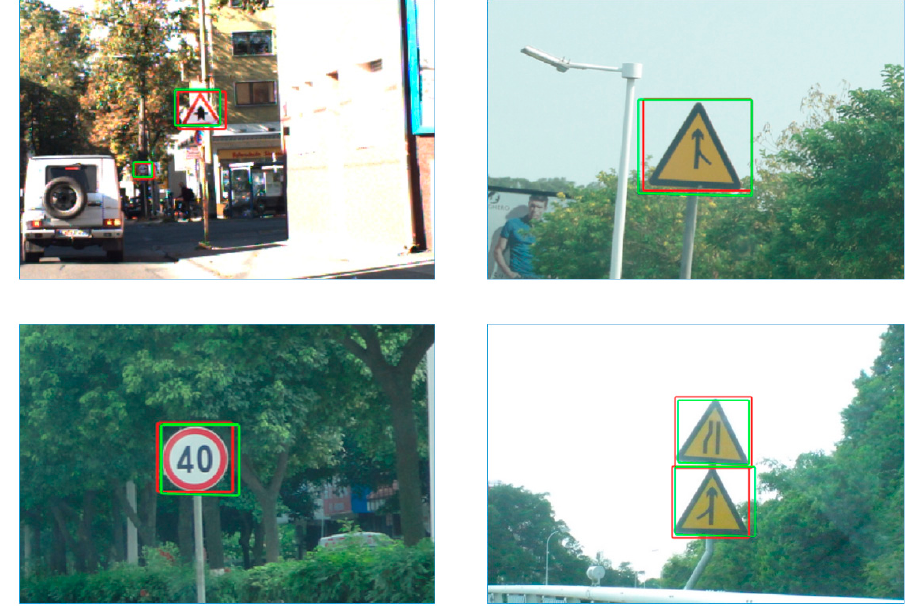
Figure 20. Examples of detection results. The red box represents the traffic signs mark area in the databases, the green box represents the detected areas. databases, the green box represents the detected